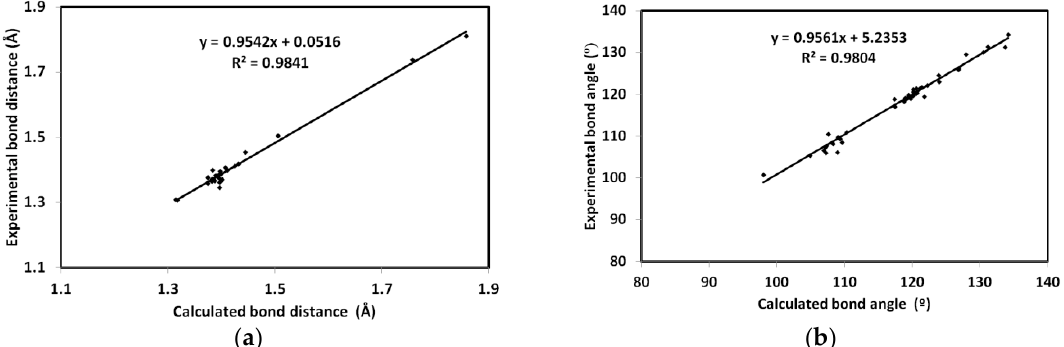
Figure 7. The straight-line correlations between the calculated and experimental bond distances ( a ) and angles ( b ).